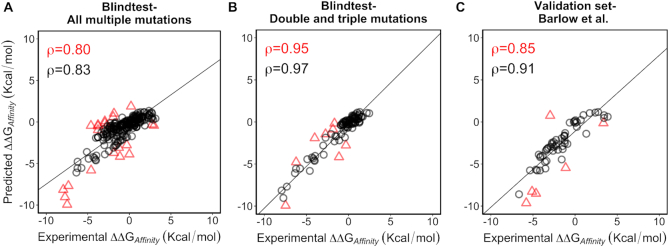
Performance of mmCSM-AB on multiple mutations. The figure depicts the performance of the final mmCSM-AB model on independent blind tests. The method achieved a Pearson's correlation of 0.80 (RMSE = 1.30) on all multiple missense mutations (242 in total) (A) and 0.95 (RMSE = 0.91) on double and triple mutation (101 in total) (B). Performance increases to 0.95 and 0.97, respectively, after 10% of outliers are removed. On an additional validation set comprised of 59 multiple mutations, mmCSM-AB achieved a correlation of 0.85 (RMSE = 1.66) (C), increasing to 0.91 across 90% of the data.